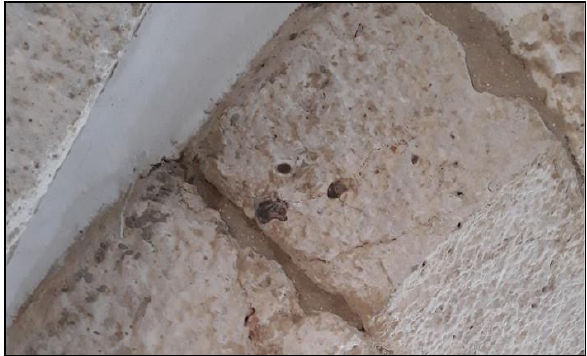
Figure 12. Silica (dark spots) found in an ashlar of the Tower of Belém.